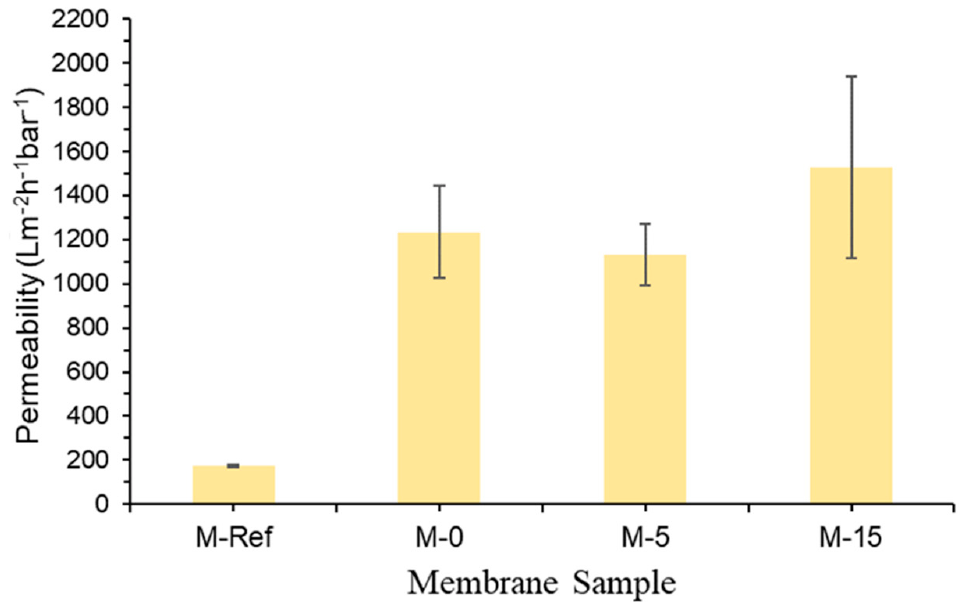
Figure 9. Clean water permeability of the developed membrane samples.